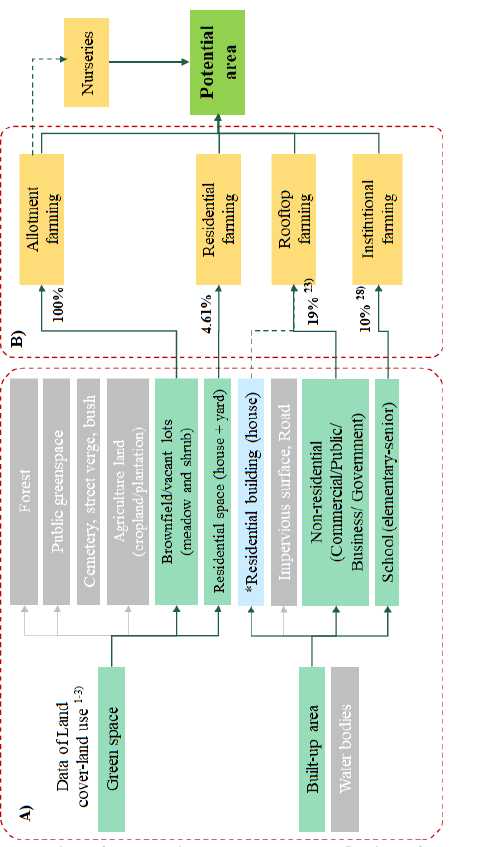
Figure 4. Identifying and mapping potential urban farming